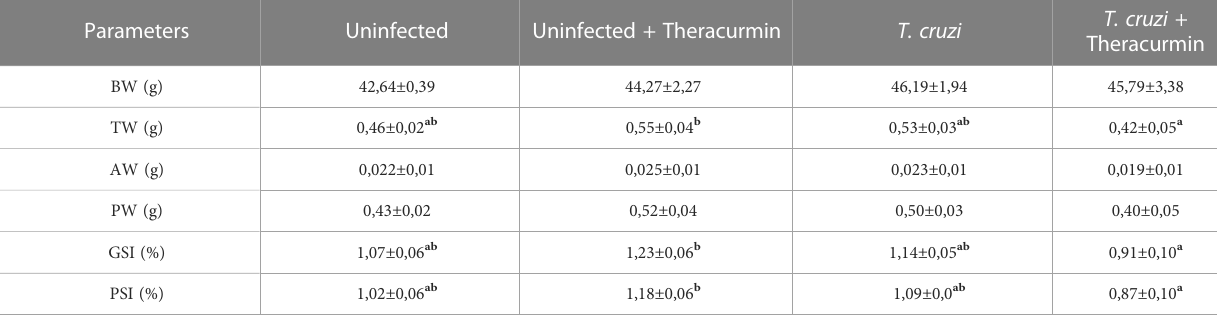
TABLE 1 Biometric and testicular parameters of mice infected with Trypanosoma cruzi and treated with Theracurmin.